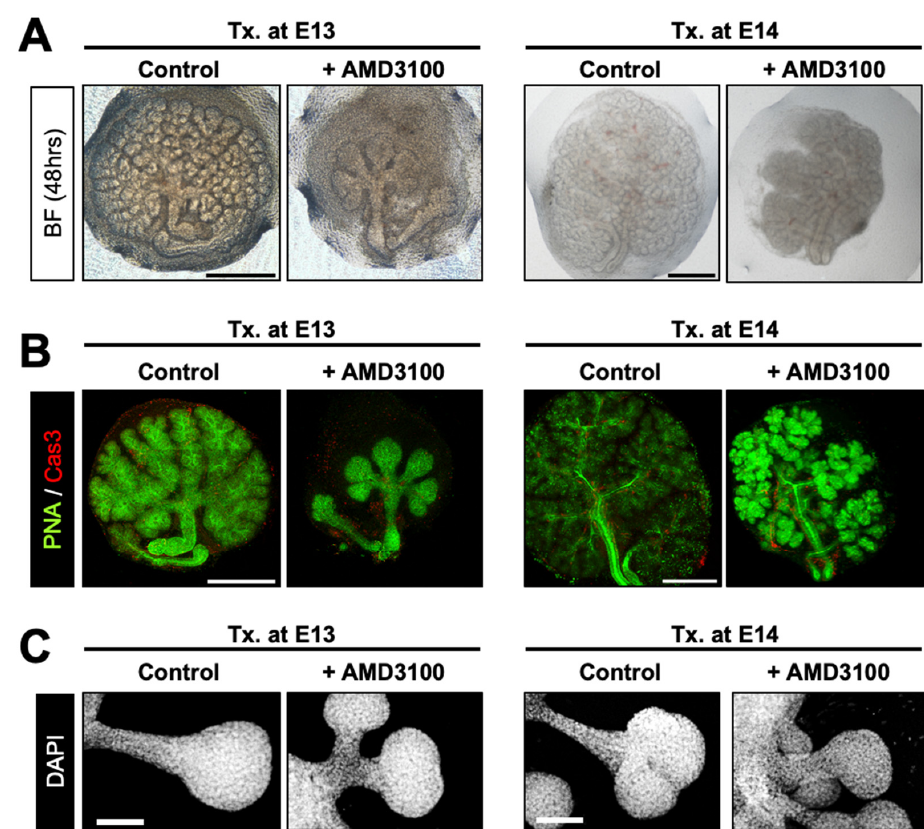
Figure 2. AMD3100-induced suppression of glandular organogenesis without cell death. ( A ) Representative bright-field images of eSMGs treated with AMD3100 at E13 (left column) and E14 (right column), respectively. Images were taken at 48 h after the treatment ( n = 4, scale bar: 500 µm). ( B ) Immunostaining results of peanut lectin agglutinin (PNA, green) and cleaved caspase-3 (Cas3, red) of eSMGs treated with AMD3100 at E13 (left column) and E14 (right column), respectively. Images were taken at 48 h after the treatment ( n = 4, scale bar: 500 µm). ( C ) The epithelial rudiments of eSMGs were cultured and treated with AMD3100 at E13 (left column) and E14 ( right column), respectively. DAPI in gray. Images were taken at 48 h after the treatment ( n = 4, scale bar: 100 µm).